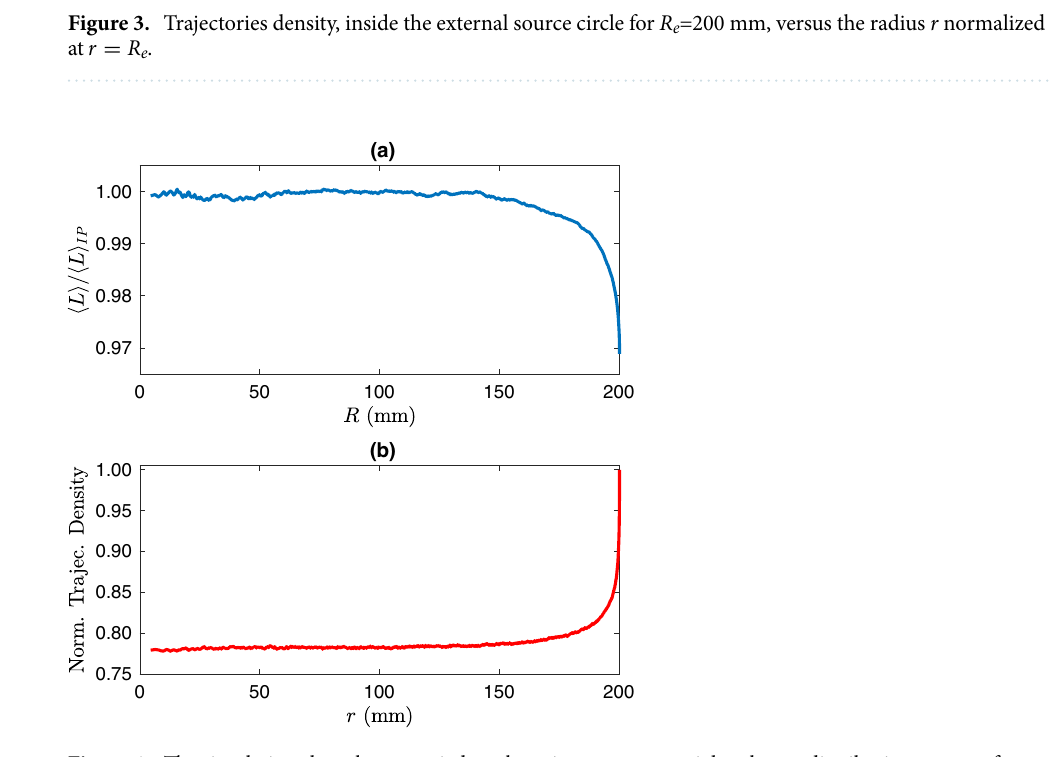
Figure 4. The simulations have been carried out by using an exponential path step distribution, a mean free path of 50 mm and R e =200 mm. ( a ) Average path length of the synthetic walkers inside the inner circle of radius R normalized to the IP value. ( b ) Trajectories density for synthetic walkers: the values are reported versus the radius r and normalized at r = R e